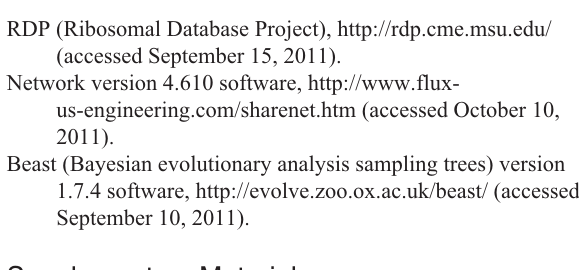
Figure S1 - Median-joining network of Wolbachia 16S rDNA sequences from Balloniscus